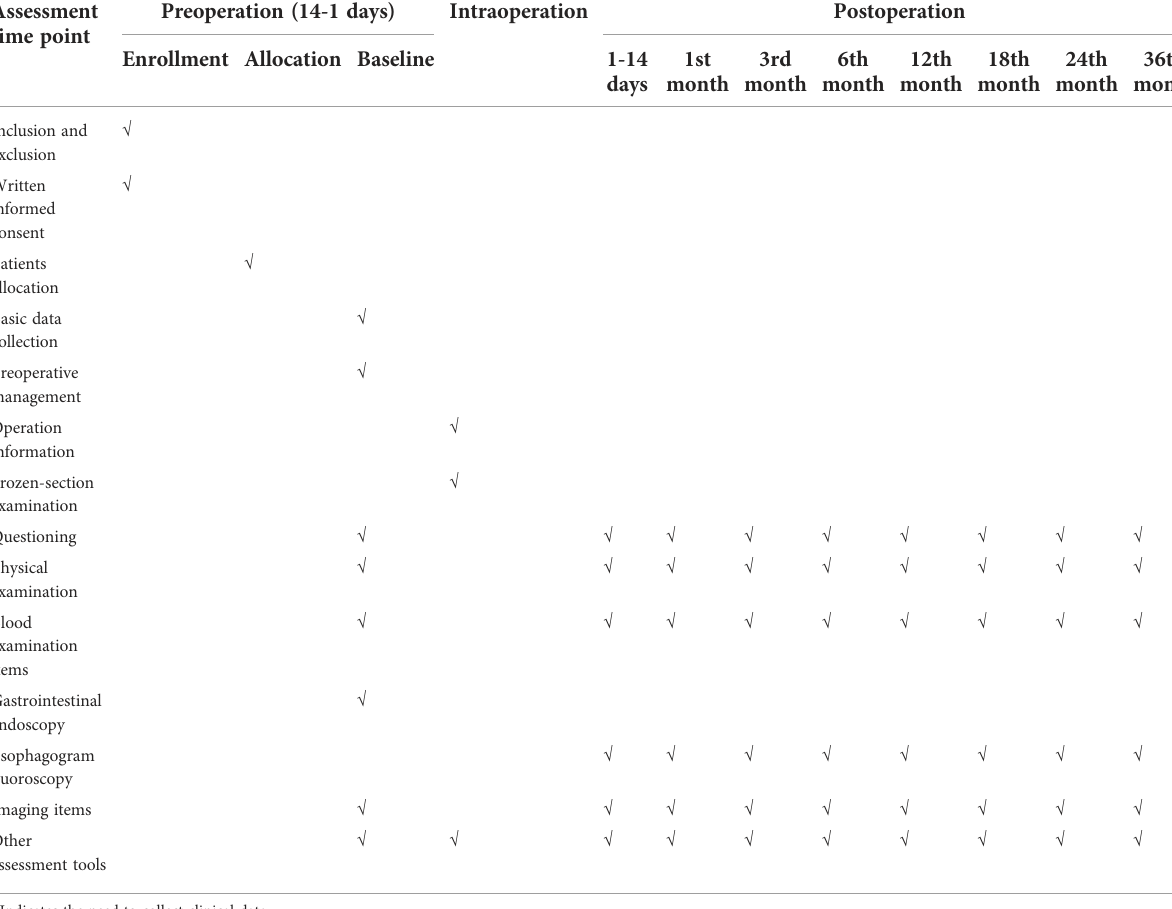
TABLE 3 The 6 medical institutions participating in the clinical